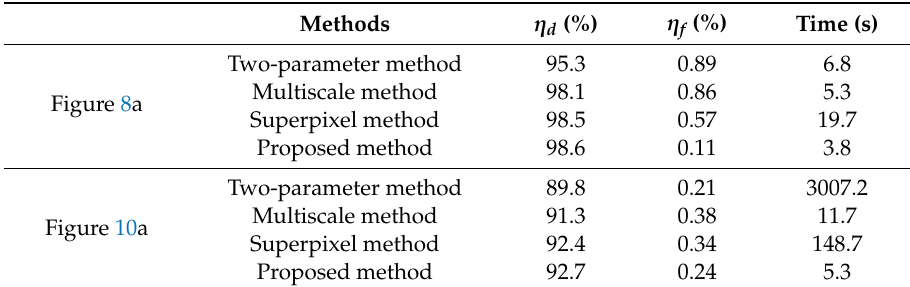
Table 1. Detection performance comparisons ( P fa = 10 − 6 ).